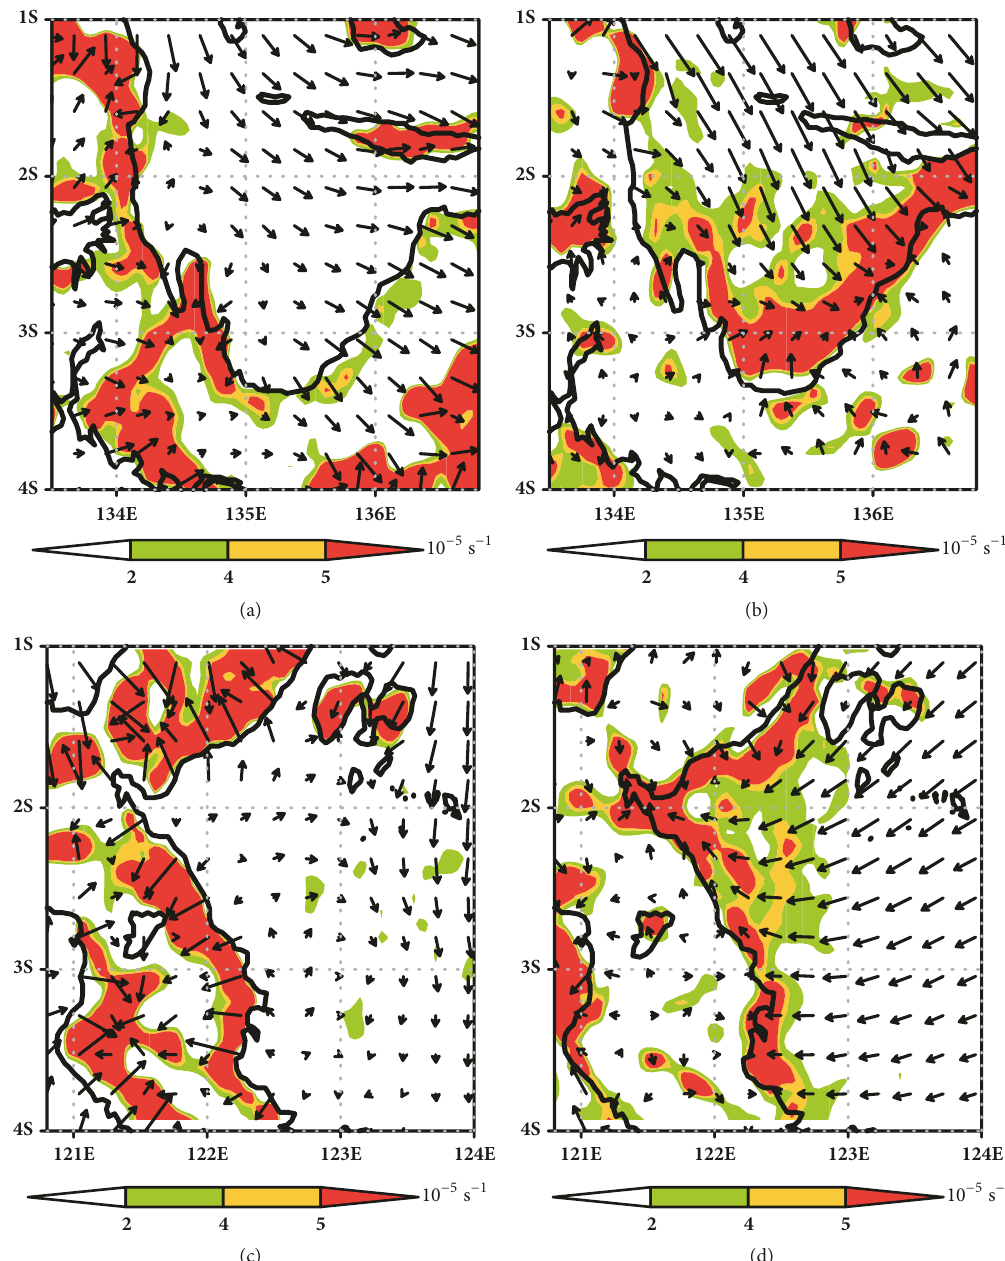
Figure 7: Low level convergence zone over Cenderawasih Bay during (a) daytime (12 am) and (b) nighttime and low level convergence zone over Tolo Bay during (c) daytime (12 am) and (d)